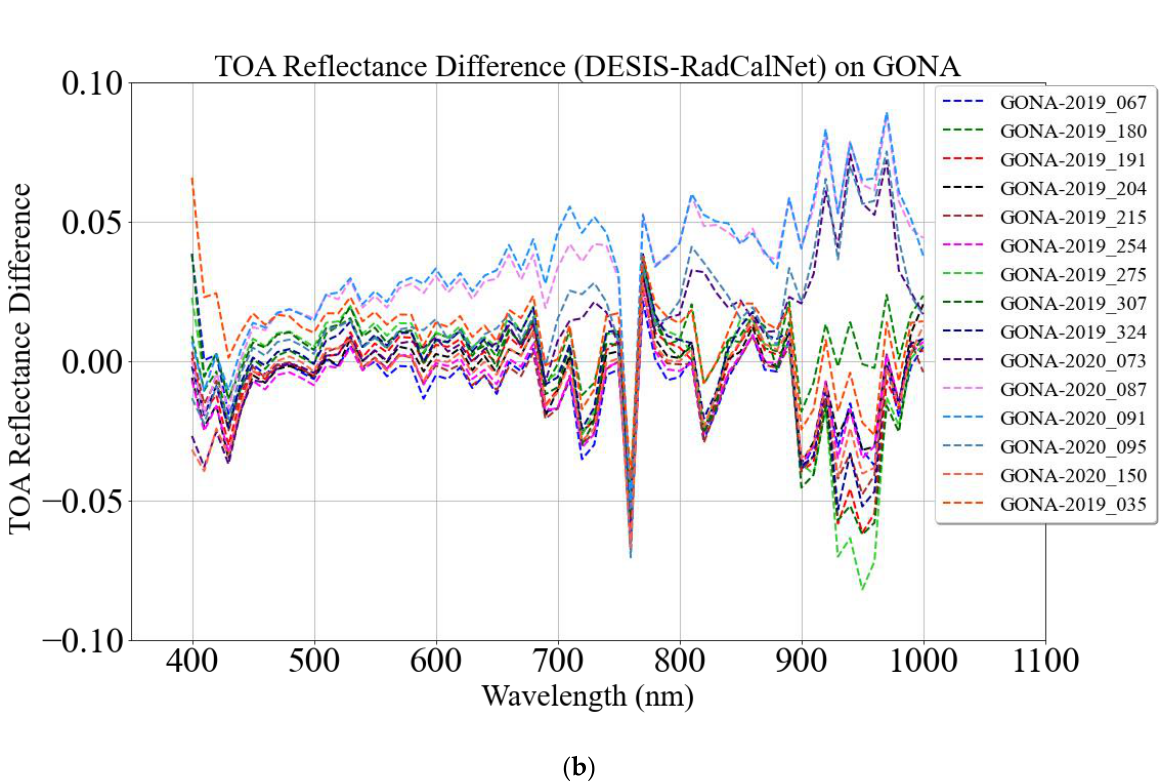
Figure 11. DESIS normalized TOA reflectance on GONA ( a ). Absolute TOA difference between DESIS and RadCalNet TOA reflectance ( b ).